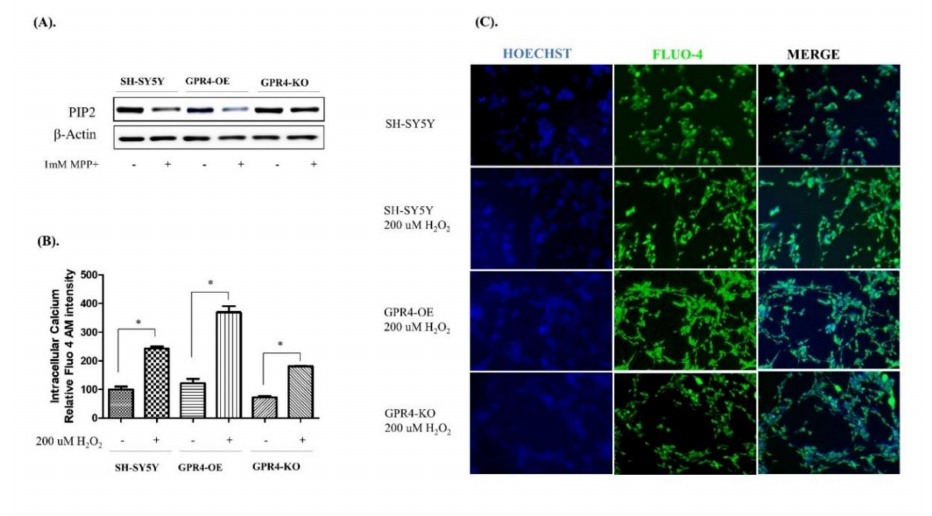
Figure 8. Phosphatidylinositol biphosphate (PIP 2 ) calcium signalling and intracellular calcium levels in MPP + -treated SH-SY5Y cells that were stably GPR4-OE or GPR4-KO. 24 h serum-starved SH-SY5Y